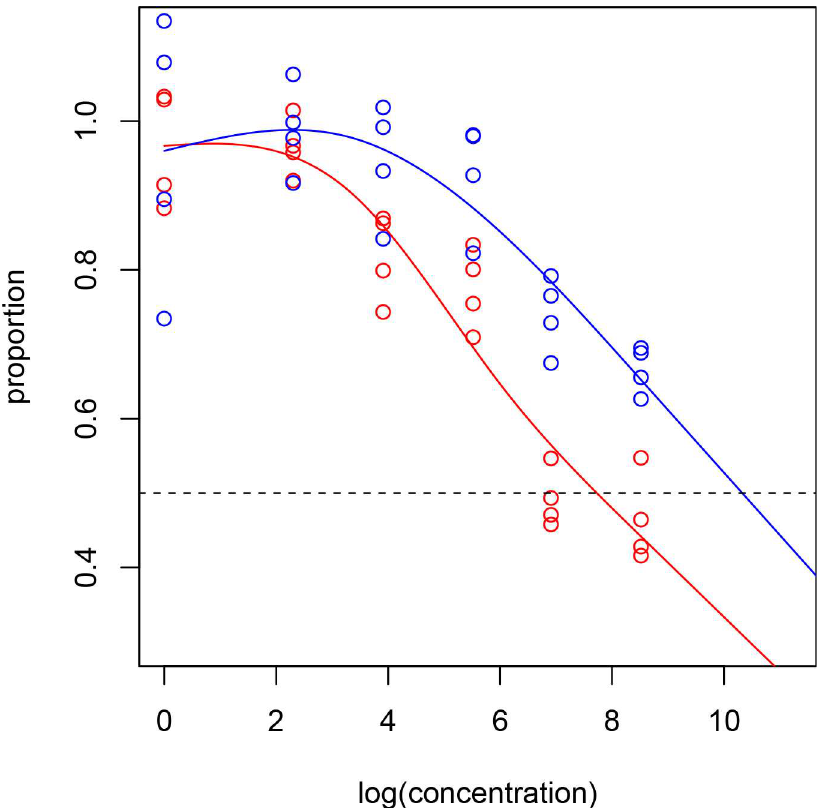
Fig 6. Higher antiproliferative potency of paclitaxel over carboplatin. OE19 cells were plated on 96-well plate and treated with 1 nM to 5000 nM concentrations of paclitaxel(red points) or carboplatin(blue points). After 72 hours, 10 μ l WST-1 reagent was added in each well and incubatedfor 2 additionalhours. The absorbance at 450 nm was measuredusing a microplatereader. The resultingnumberof viable cells was calculatedby measuringabsorbance of color produced in each well. Data are the mean ± SD of